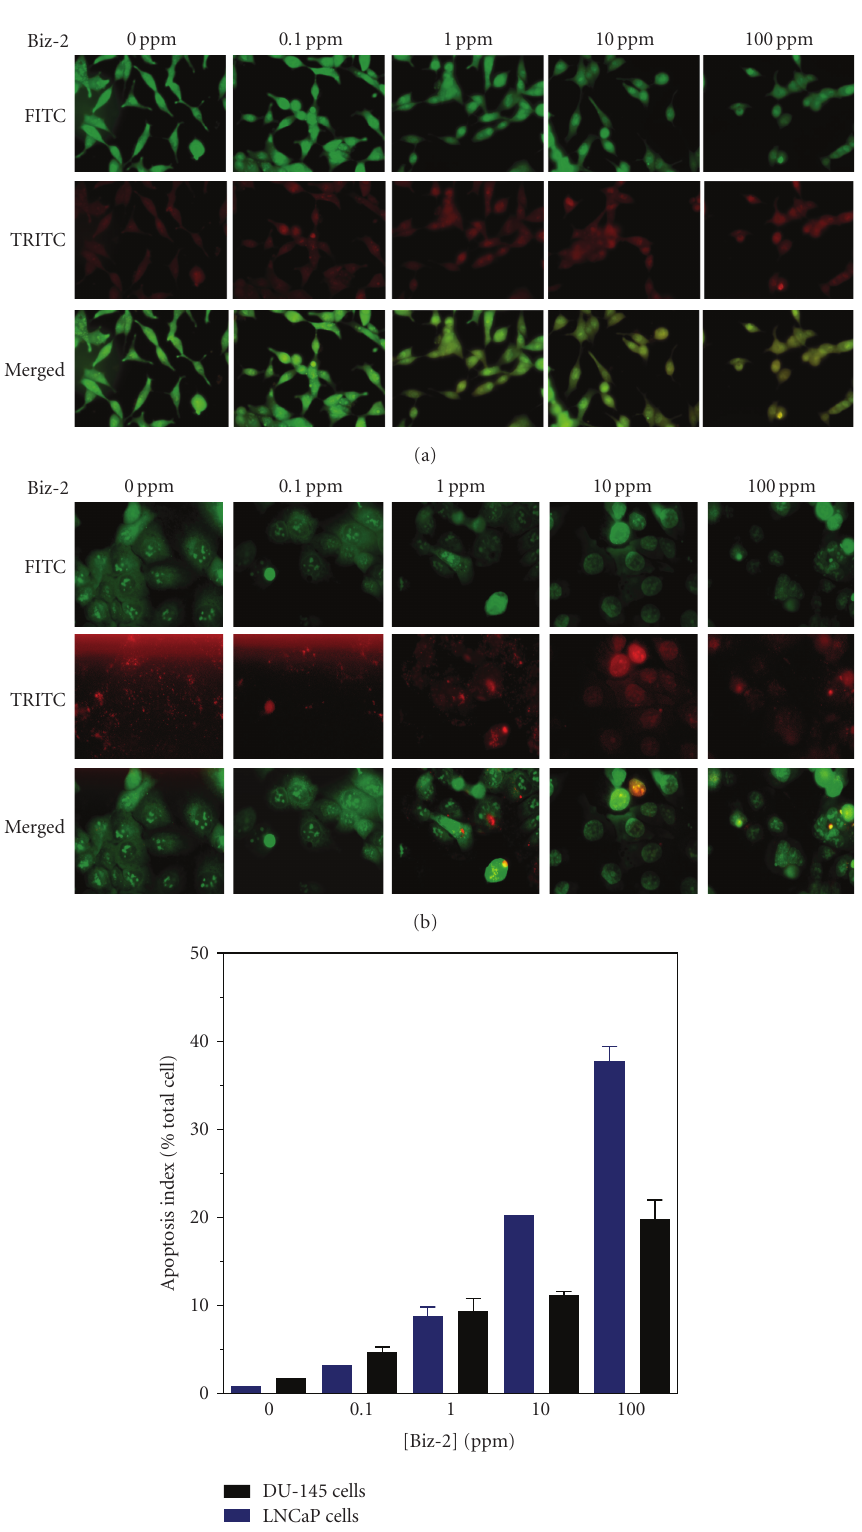
Figure 6: Cellular and nuclear morphology indicative of apoptosis induced by Biz-2. LNCaP cells were grown on a microscope slide, then induced with 1 or 100 ppm of Biz-2 for 24 hours. Cells were stained with a solution of acridine orange and ethidium bromide for 5 minutes, then examined by light microscopy. (a) Confocal laser fluorescent microscope images taken with a 550nm filter (Top panel: acridine orange, middle panel: ethidium bromide, bottom panel: both). (b) Apoptotic index was determined. We calculate the apoptotic index by averaging the number of apoptotic cells per field (70–60 cells), then dividing by the total number of cells perfield (120–140 cells) (total number of cells − total number of apoptotic cells)/(total number of